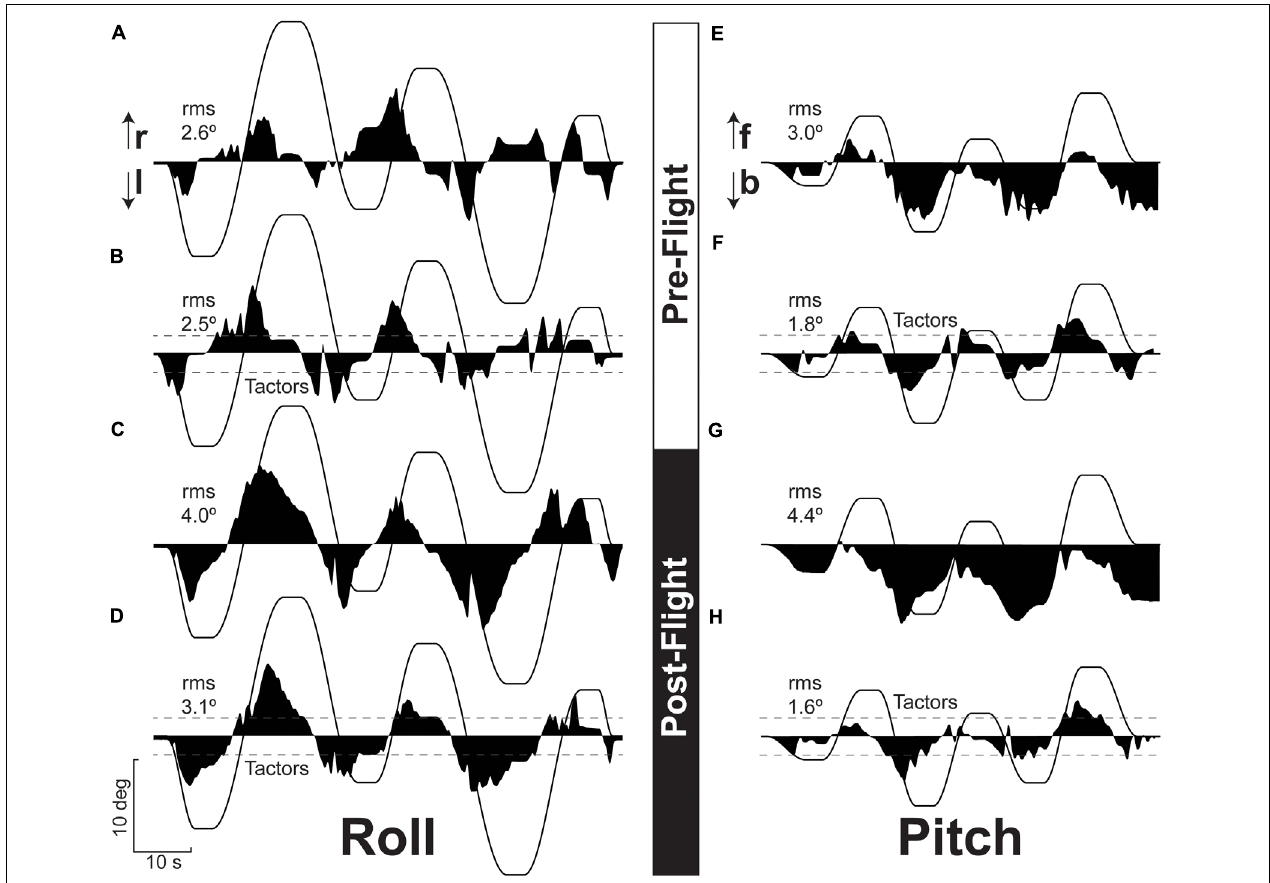
FIGURE 2 | Typical recordings of residual chair tilt after nulling (dark area) in response to imposed chair tilt (thin line) in roll (left side) and pitch (right side) before (top half) and after (bottom half) spaceflight without and with tactile tactile feedback. Performance without vibrotactile feedback is shown in (A,C,E,G) . Performance during the same sessions with vibrotactile feedback is shown in (B,D,F,H) . The dashed lines on these traces indicate the lowest threshold at which vibrotactile feedback was provided. The RMS error value for each test in also reported. r, right, l, left; f, forward; b,